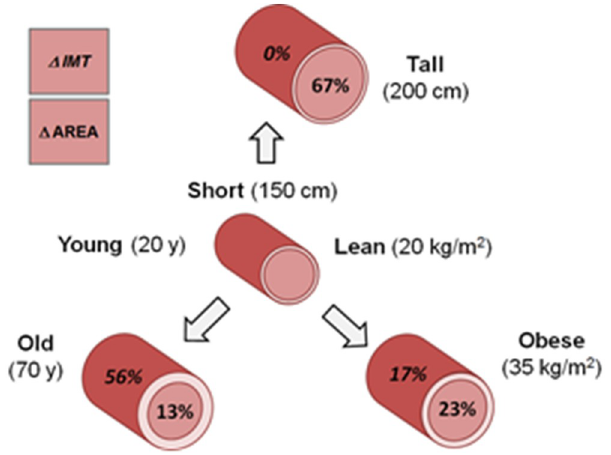
Figure 2. Hypothetical cross-sections of the common carotid artery showing the estimated percentage differences in internal lumen areas and intima–media thicknesses between a short, young, normal (Nl) weight reference person and their tall, old, and obese counterparts. Calculations are based on respective CCAD and IMT prediction equations #1 and #2 in the text and Table S1.